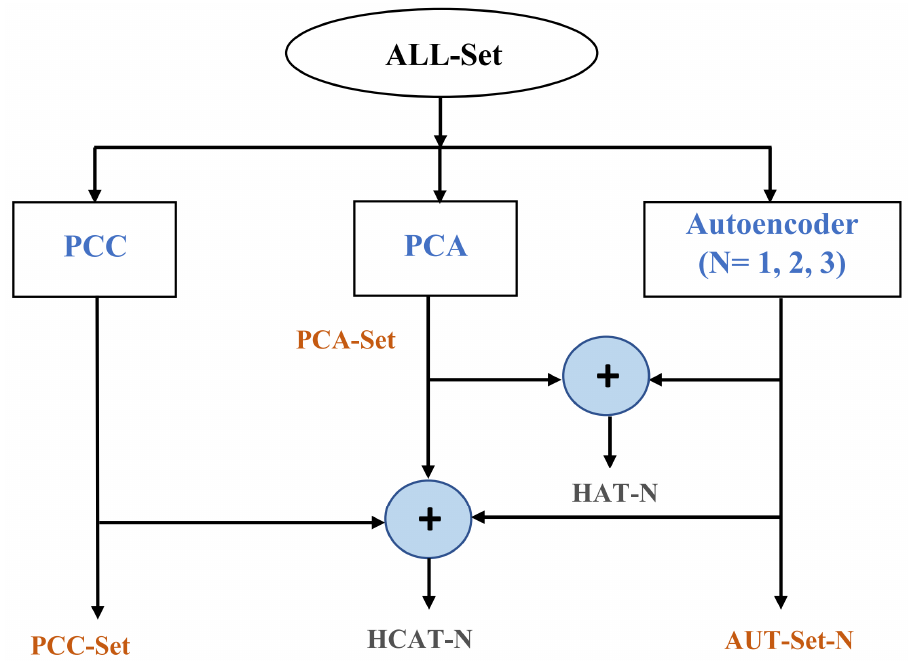
Figure 3. The feature formation phase of the proposed framework; ‘+’ represents the fusion between feature sets.